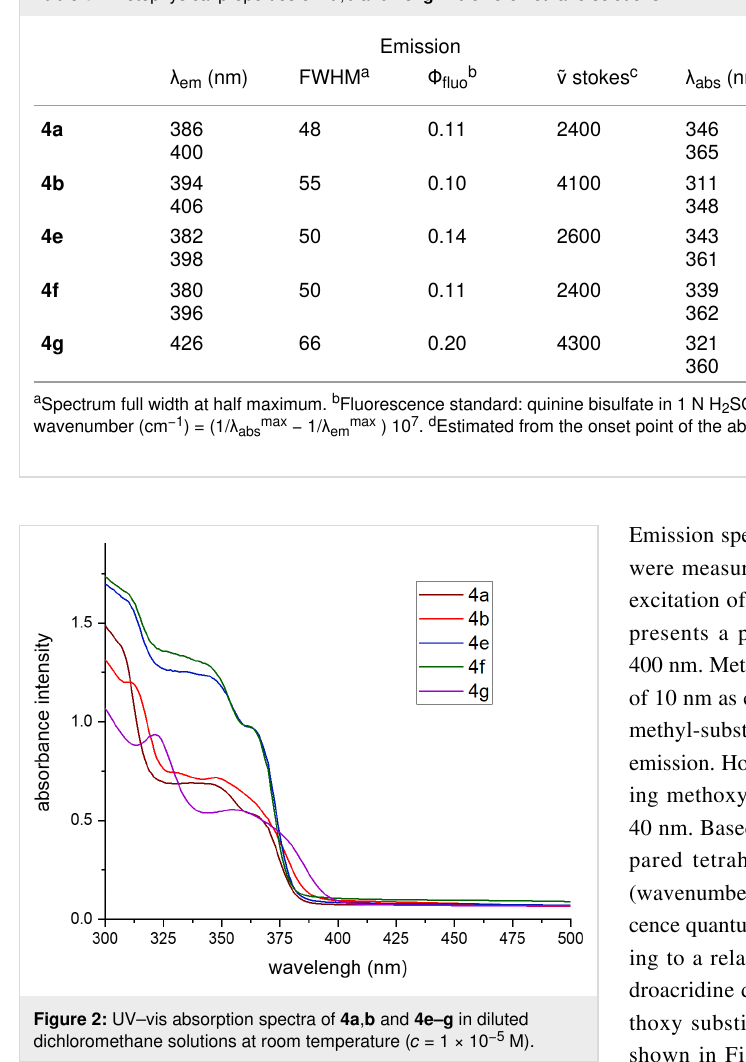
Table 3: Photophysical properties of 4a , b and 4e–g in dichloromethane solutions.